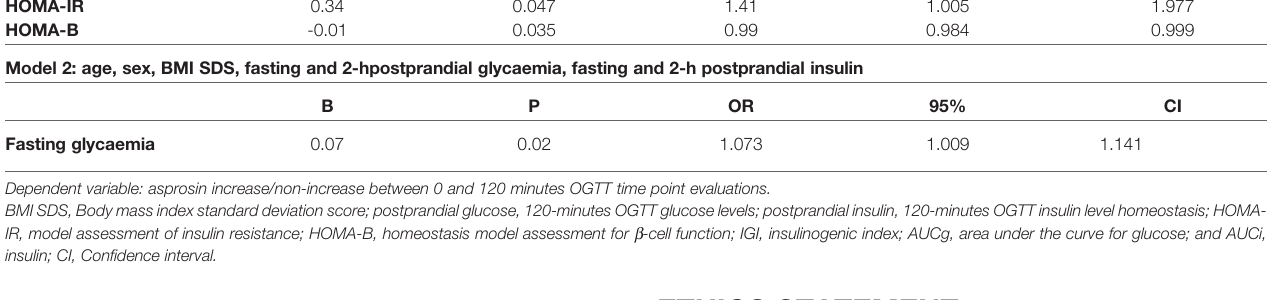
TABLE 5 | OR and 95% Con fi dence interval (CI) for impaired fasting glucose according to asprosin increase. Models